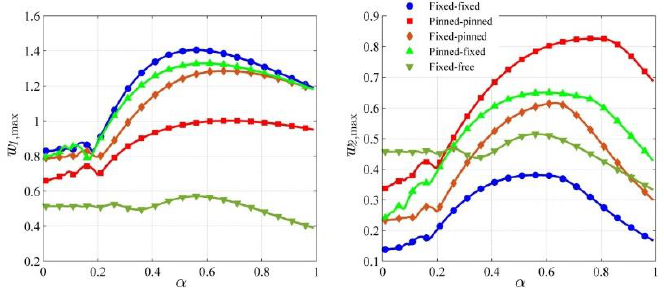
Figure 14. Maximum displacement ratios 𝑤̅ 1,max and 𝑤̅ 2,max versus speed ratio 𝛼 for different boundary conditions when 𝑠 e = 100 , 𝑠 m = 1 and 𝑠 k = 1 .